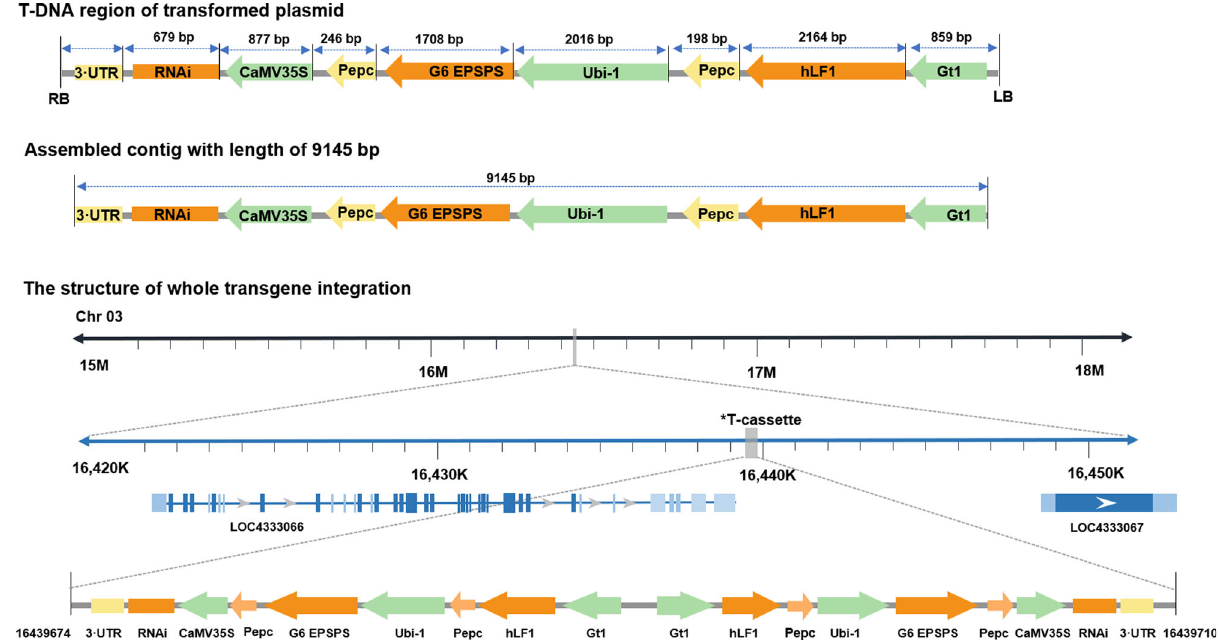
Fig. 3 Schematic diagram of whole transgene integration in G281 rice. RB, right border of T-DNA; LB, left border of T-DNA; Gt1 , rice glutelin promoter; hLF, human lactoferrin; G6 EPSPS , the 5-enolpyruvylshikimate-3-phosphate synthase isolated from Pseudomonas putida fused with a corn chloroplast transit peptide at the N-terminus (gb: EU169459); RNAi, reverse repeat sequence for RNA interference against CYP81A6 ; CaMV35S, cauli fl ower mosaic virus 35S promoter; ZmUbi, polyubiquitin-1 promoter of Zea mays ; PEPC, phosphoenolpyruvate carboxylase terminator of Zea mays